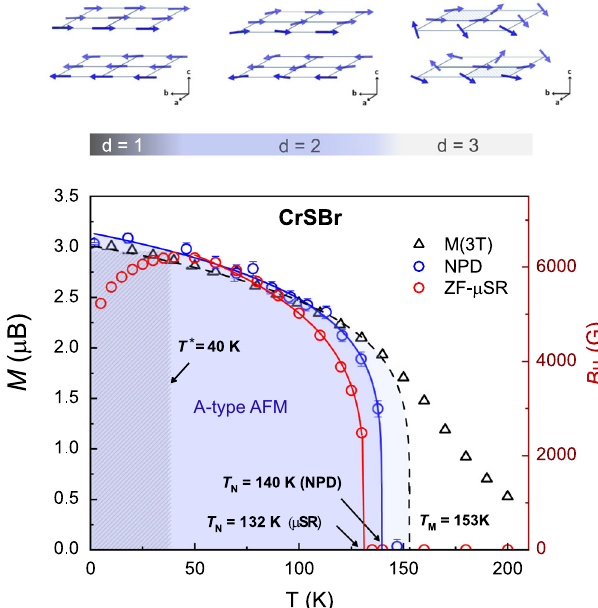
Fig. 7 | Phase diagram of CrSBr. Blue open circles show the magnetization values derived from the neutron powder diffraction (NPD) data, corresponding to the stablishing of the long-range A-type magnetic structure (blue region). The satura- tion values of the magnetization M (3T) are shown as black triangles, highlighting the precursor magnetic state below T M ≈ 153K. Above T M , high magnetization values are still observed, re fl ecting an enhanced magnetic susceptibility at high temperature (i.e., in the paramagnetic state). Red open circles show the internal fi eldderived from theZF- μ SRdata(rightscale,inred),showingthe decreaseinthe internal fi eld ( B μ ) across the spin-freezing process. The error bars represent the standard deviation of the fi tted parameters. Upper panel schematically show the proposed spin dimensionality (d)